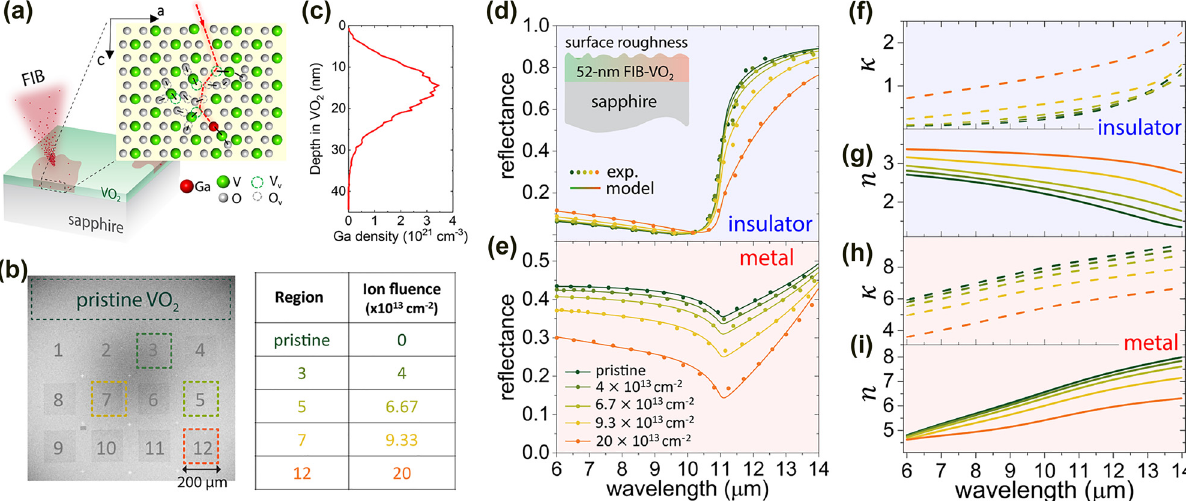
. Figure 3: FIB-induced changes in the optical refractive index of VO 2 using a FIB system, with an inset schematic of the defect-engineering process, showing a collision cascade in the (a) Ion irradiation of VO 2 lattice initiated by an energetic Ga ion. (b) SEM image of the FIB-irradiated VO regions with the corresponding ion fluences listed. (c) VO 2 2 thin film using TRIM. (d, e) The symbols are FTIR reflectance measurements on pristine Simulated depth profile of 30-keV Ga ions into a VO 2 and regions irradiated with ion fluences of 4 × 10 13 , 6.7 × 10 13 , 9.3 × 10 13 , 20 × 10 13 cm − 2 , for temperatures at 25 ◦ C (all regions in pure VO 2 insulating phases) and 100 ◦ C (all regions in pure metallic phases), respectively. The solid curves are the model fits to the FTIR . The insulator-phase (f, g) and metal-phase measurements, where the underlying model was created based on ellipsometry of pristine VO 2 (h, i) refractive indices were extracted from the fittings shown in (d) and